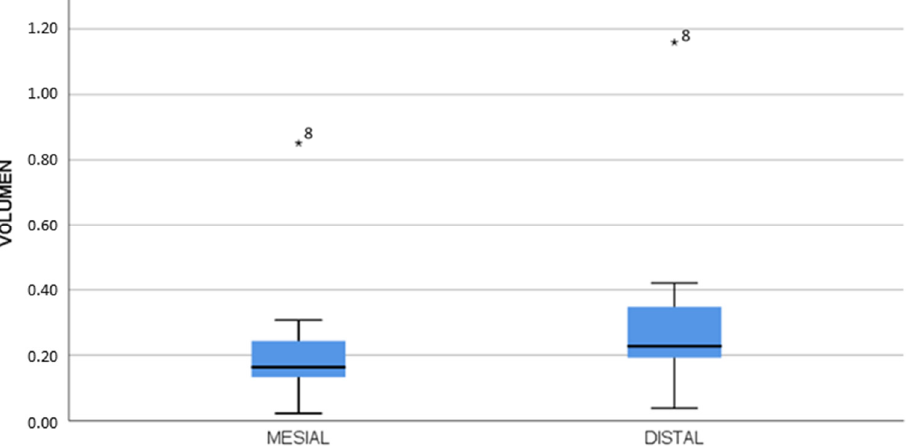
Figure 9. Box plot of the volume of the enamel removed after the interproximal enamel reduction procedure at the mesial and distal interproximal enamel surfaces of the STL digital files. “*” represent outliers in line 8.